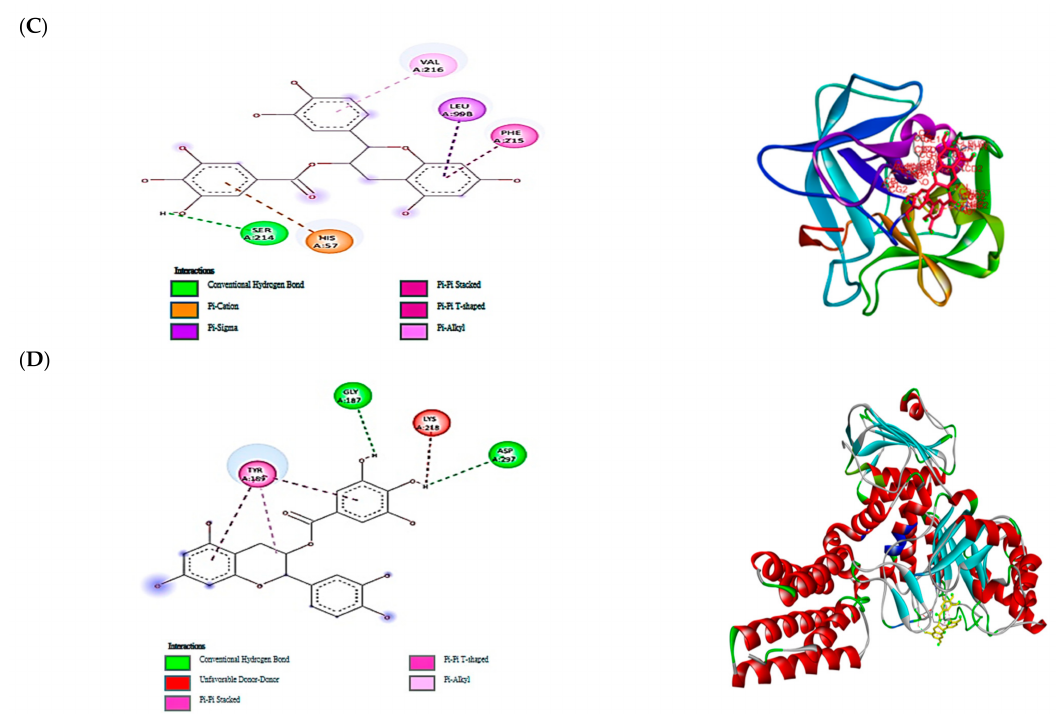
Figure 7. Docking interactions and docking complex of the optimal phytochemical compounds against tested enzymes. ( A ) Molecular docking of the interactions between quercetin and tyrosinase. ( B ) Molecular docking of the interactions between epicatechin and collagenase. ( C ) Molecular docking of the interactions between epicatechin and elastase. ( D ) Molecular docking of the interactions between epicatechin and